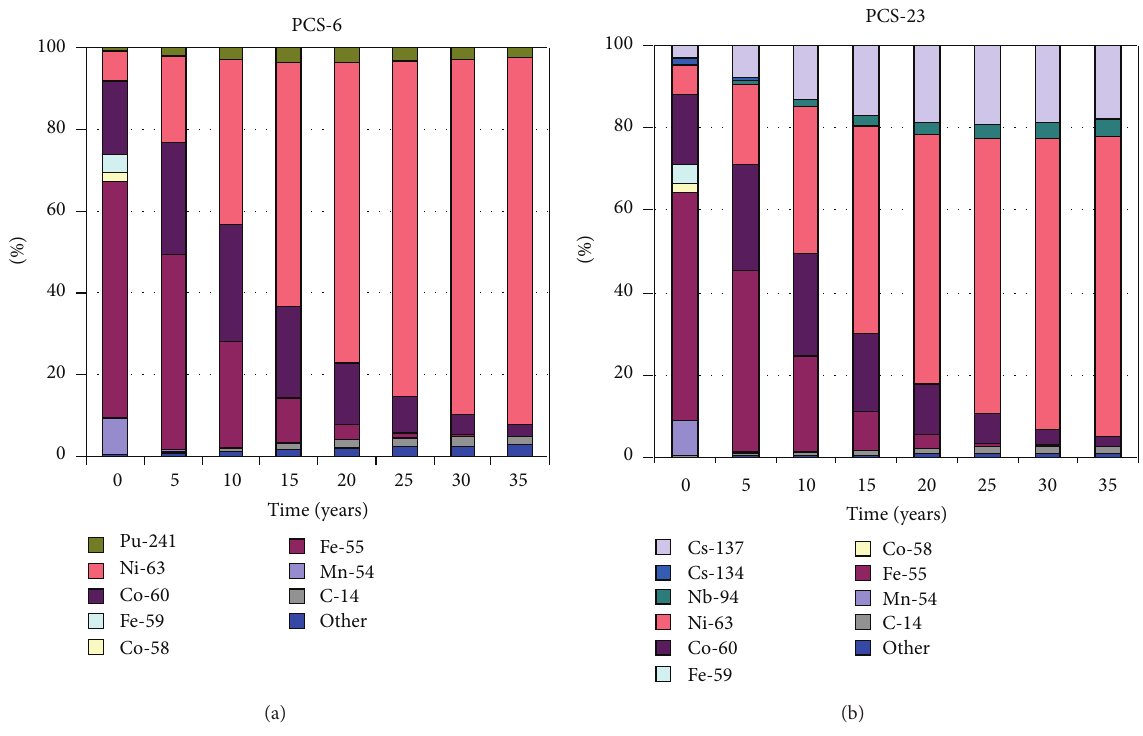
Figure 5: Activity variation of deposits of components with time: (a) PCS-6 and (b) PCS-23 (other < 1%).